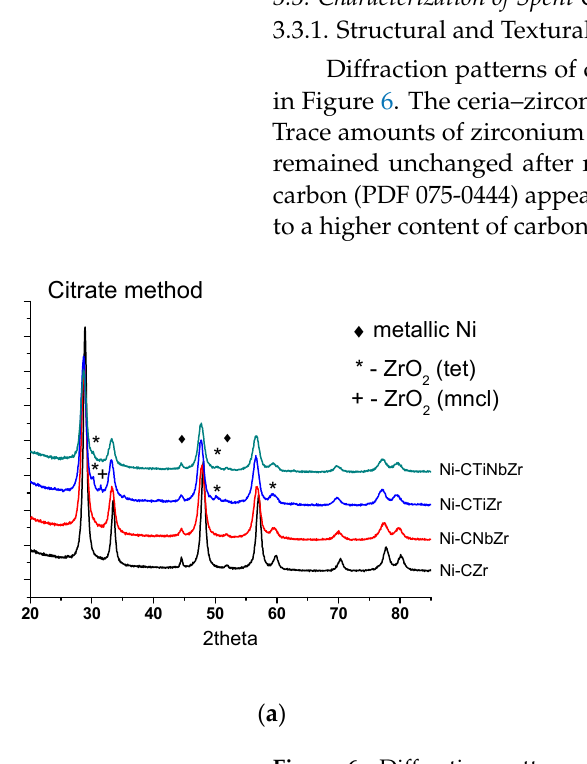
Figure 6. Diffraction patterns of catalysts prepared by citrate methods ( a ) and by supercritical synthesis ( b ) after tests in methane dry reforming.